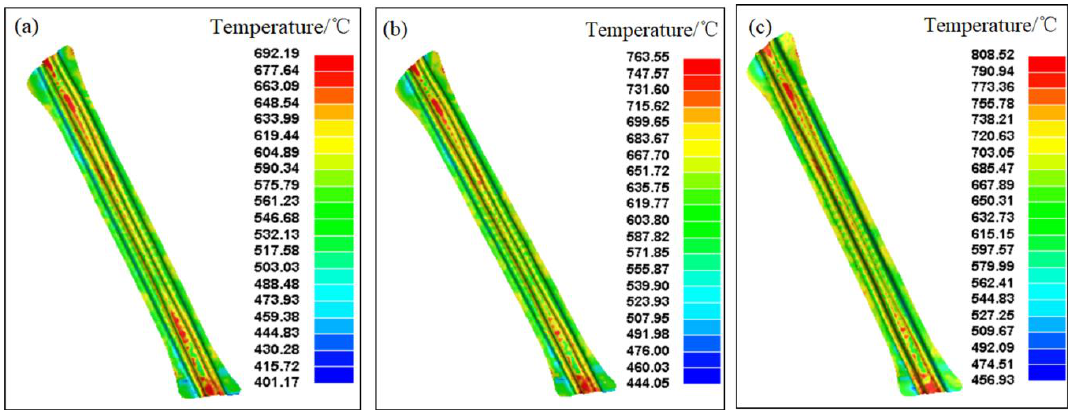
Figure 5. Temperature field distribution of formed parts at the end of hot stamping; ( a ) process 1, ( b ) process 2, and ( c ) process 3.